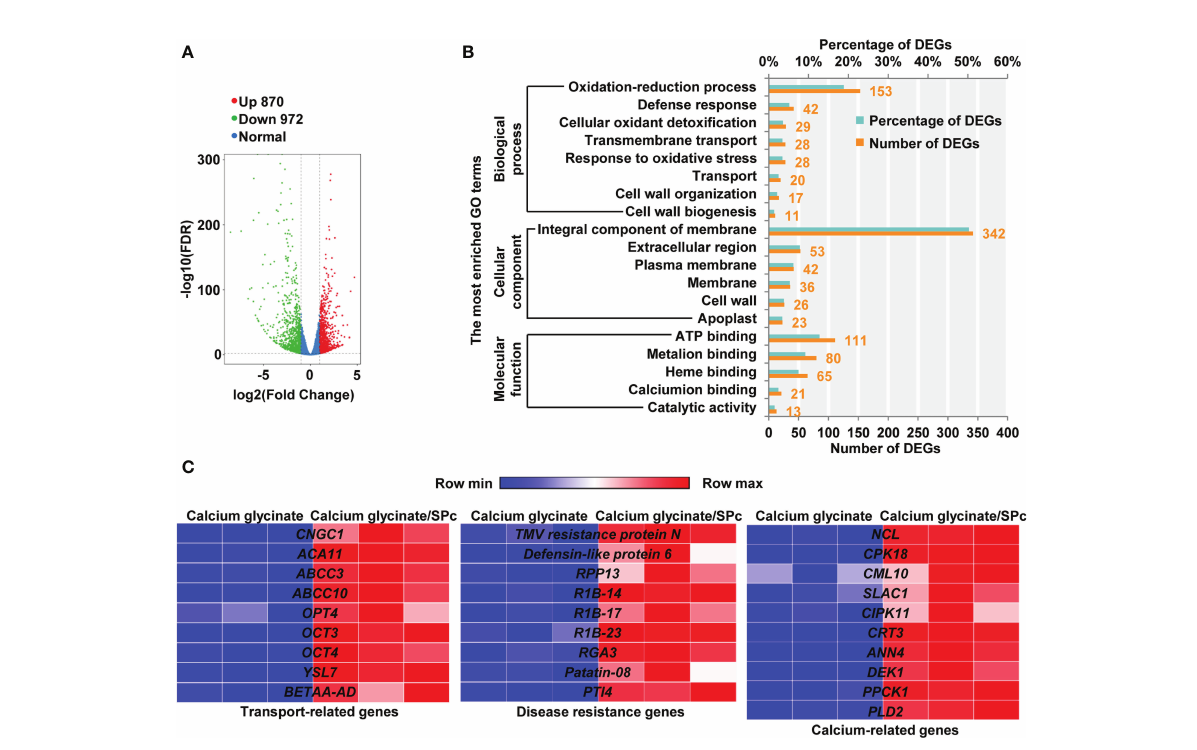
FIGURE 3 RNA-seq analysis of tomatoes treated with calcium glycinate and calcium glycinate/SPc complex. (A) Analysis of differentially expressed genes (DEGs) in tomatoes with a volcano plot. Up-regulated and down-regulated DEGs are represented by red and green dots, respectively. (B) GO enrichment analysis of DEGs in biological process, cellular component and molecular function. (C) Heatmaps of differentially expressed genes. Highly and lowly expressed genes are labeled as red and blue, respectively. Gene names are listed in the